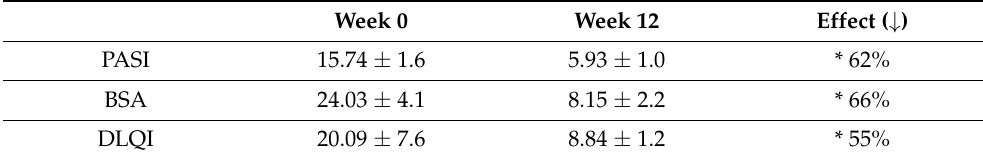
Table 4. Levels of PASI, BSA and DLQI indicators before the study (week 0) and during treatment (week 12). * indicates a statistically significant difference ( p < 0.05).